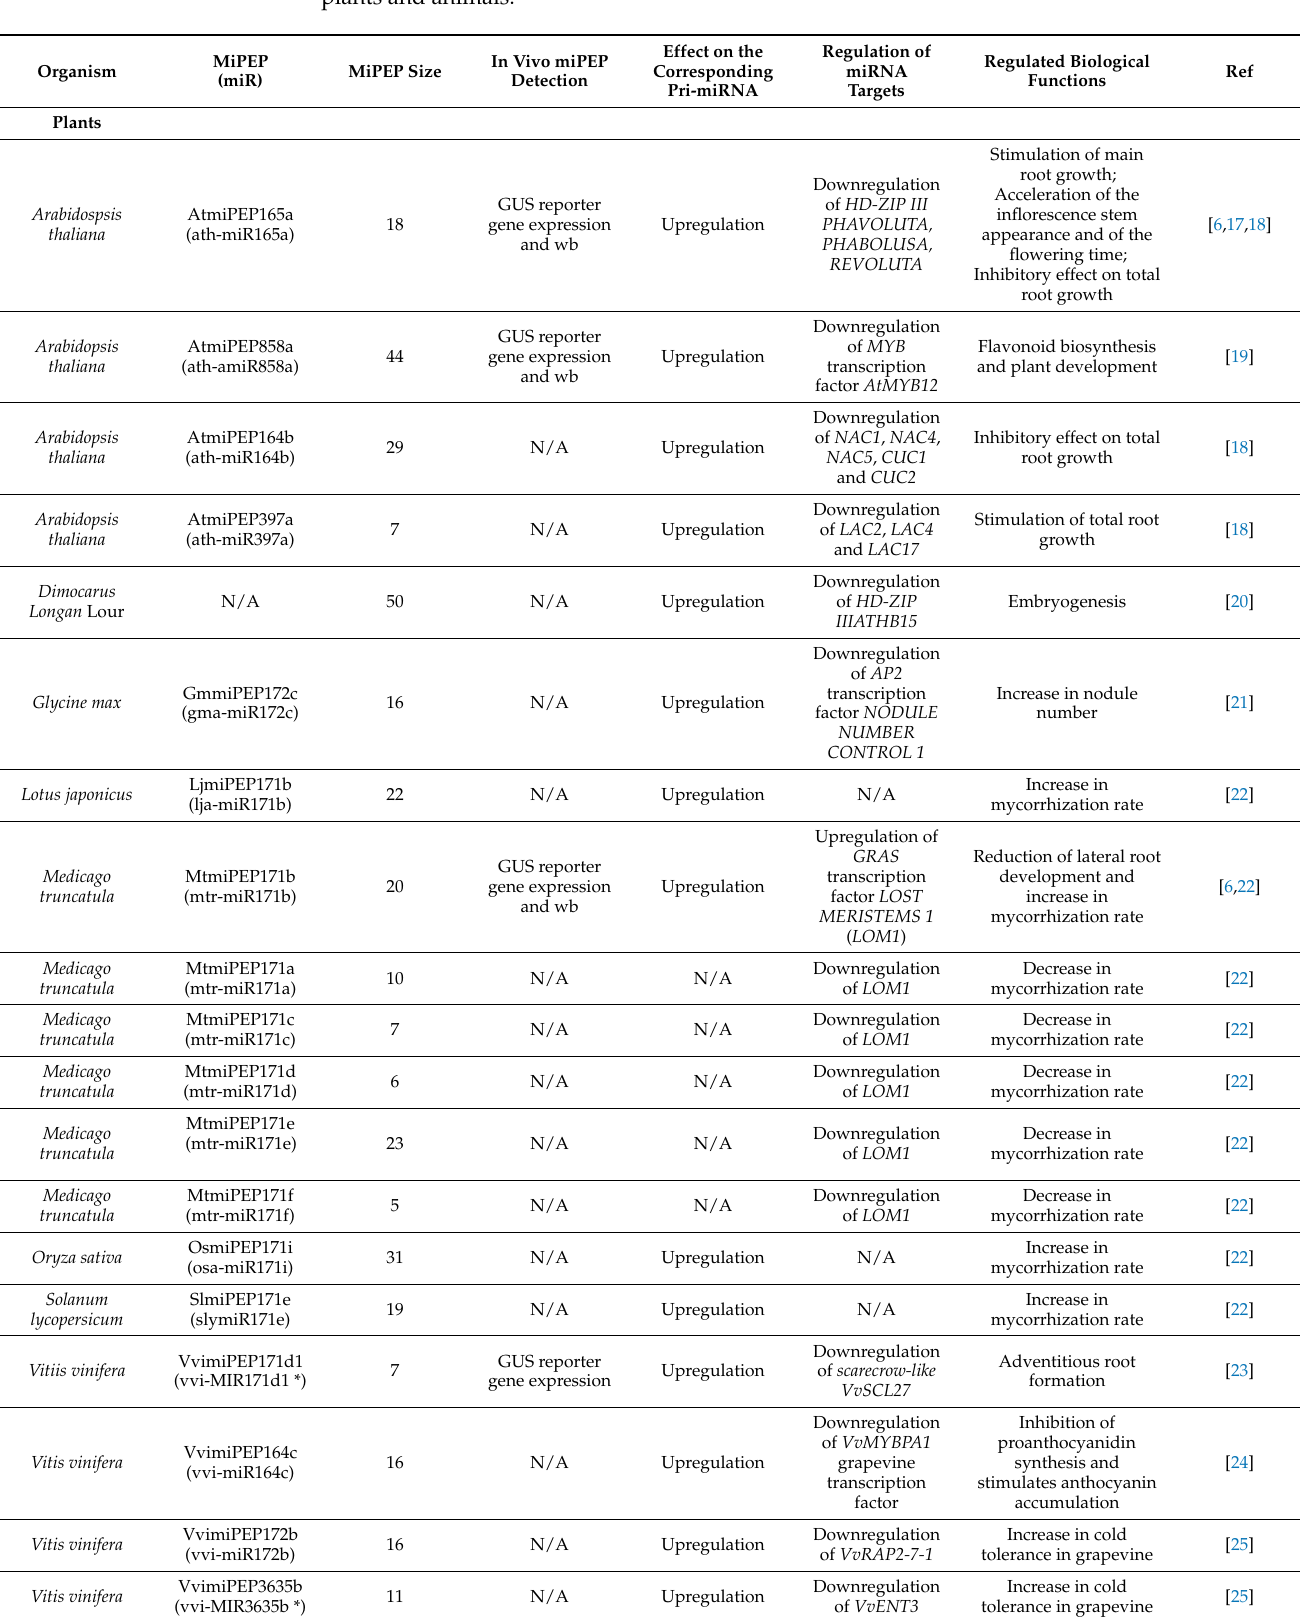
Table 1. List of miPEPs (and their embedded miRs) described in the literature (and miRbase) both in plants and